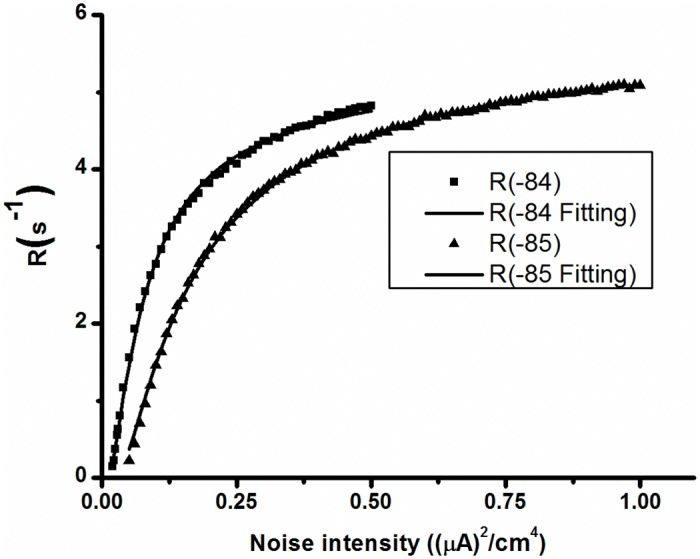
Changes of escape rate from the stable focus with respect to noise intensity.Square (triangle): simulation results when V
K = -84 mV (V
K = -85 mV); thin (bold) line: Fitting curve of simulation data when V
K = -84 mV (V
K = -85 mV) manifesting exponential function.